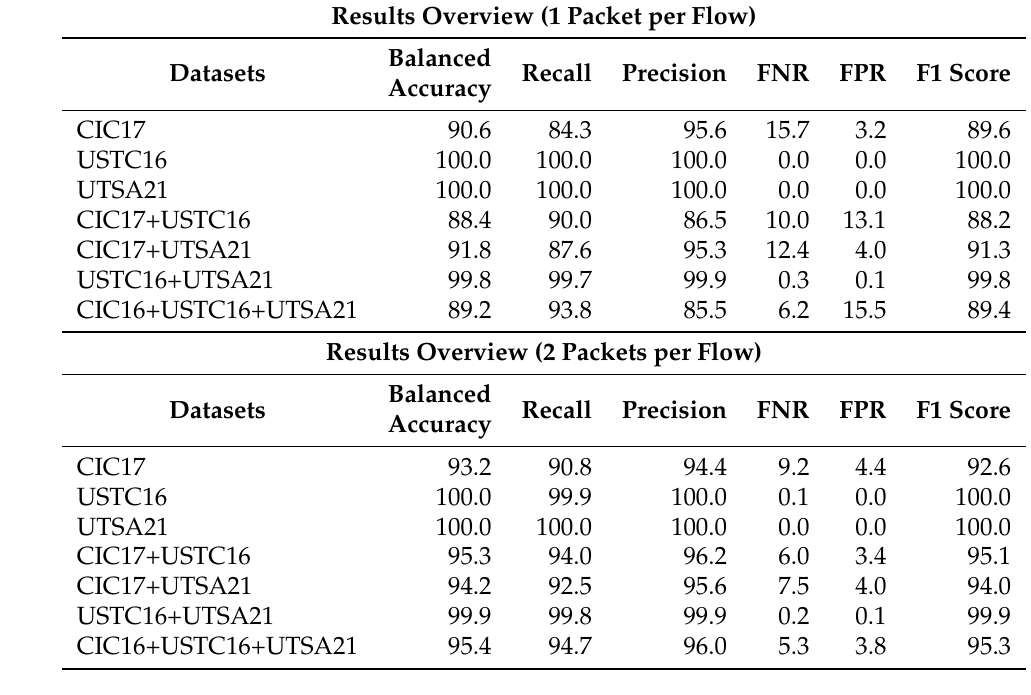
Table 4. An overview of the results from training and testing on equal amounts from each category in each of the three datasets in various combinations as listed in Table 2. In general, any case containing CIC-DoS17 traffic demonstrates lower accuracy, but every case not containing that traffic has nearly 100%